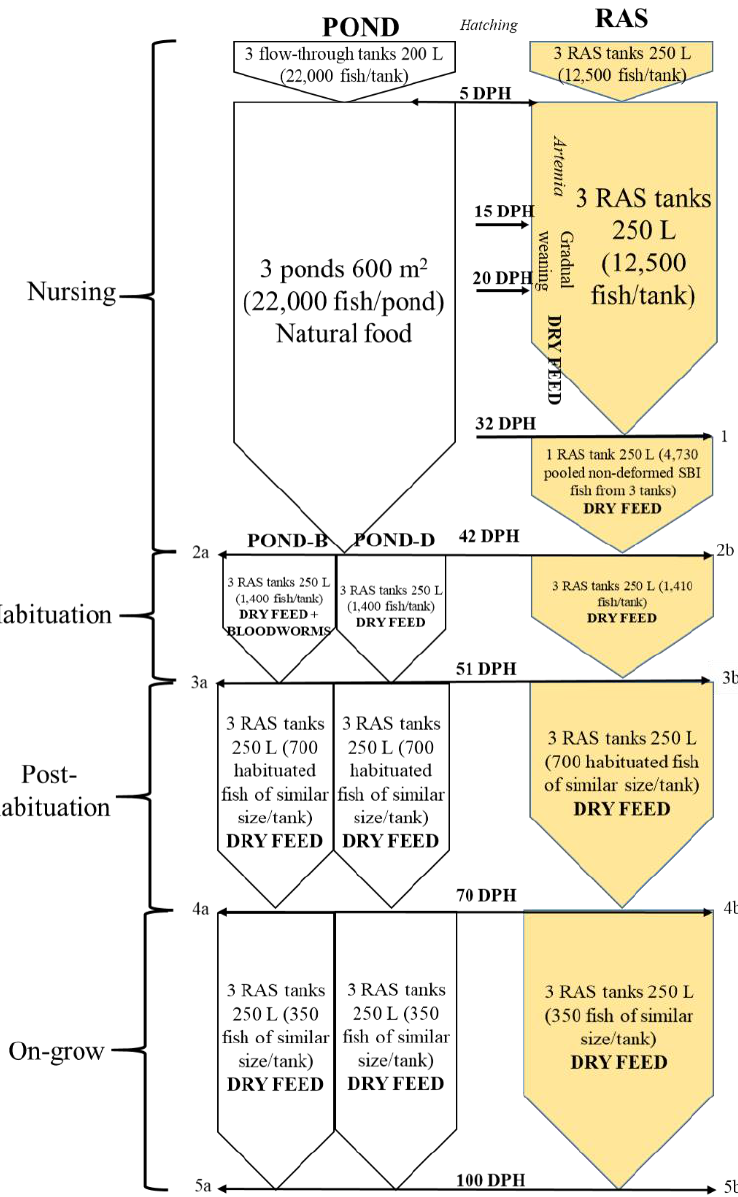
Figure 1. Flow-chart with experimental design, showing four growth/rearing phases assessed in this research: larval nursing, dry fed habituation, post-habituation and the on-growing phase. Fish sampling was performed at five points throughout the experiment: point 1 (when fish were counted and swim bladder inflation (SBI) and deformity rates estimated, along with morphometric indices in all fish), 2 (when fish were counted and morphometric indices assessed in a total of 40 fish from pond ( a ) and 30 fish from RAS ( b )), 3 (when habituated fish were counted and morphometric indices assessed in 30 fish/tank both from pond- ( a ) and RAS- ( b ) nursed fish), 4 (when fish were counted and morphometric indices estimated in all fish both from pond- ( a ) and RAS- ( b ) nursed groups) and 5 (when fish were counted and morphometric indices estimated in 100 fish/tank both from pond- ( a ) and RAS- ( b ) nursed groups).